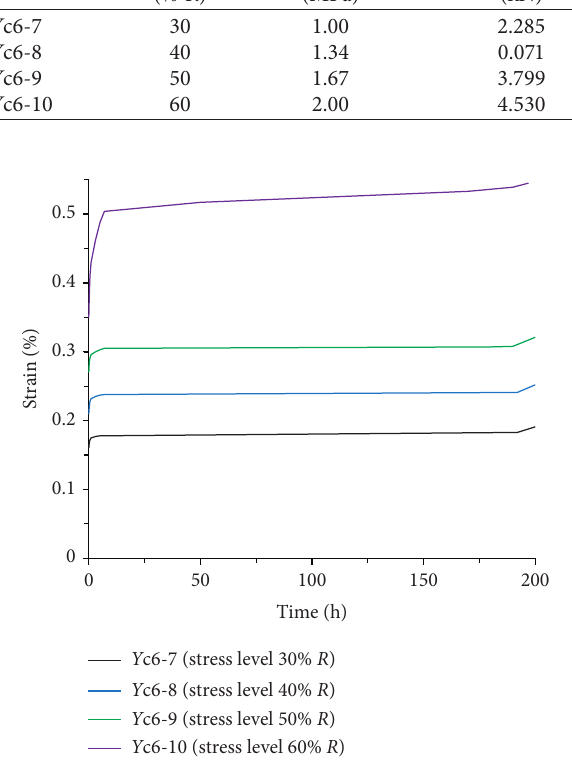
Figure 6: Creep curve of the filling body specimens.